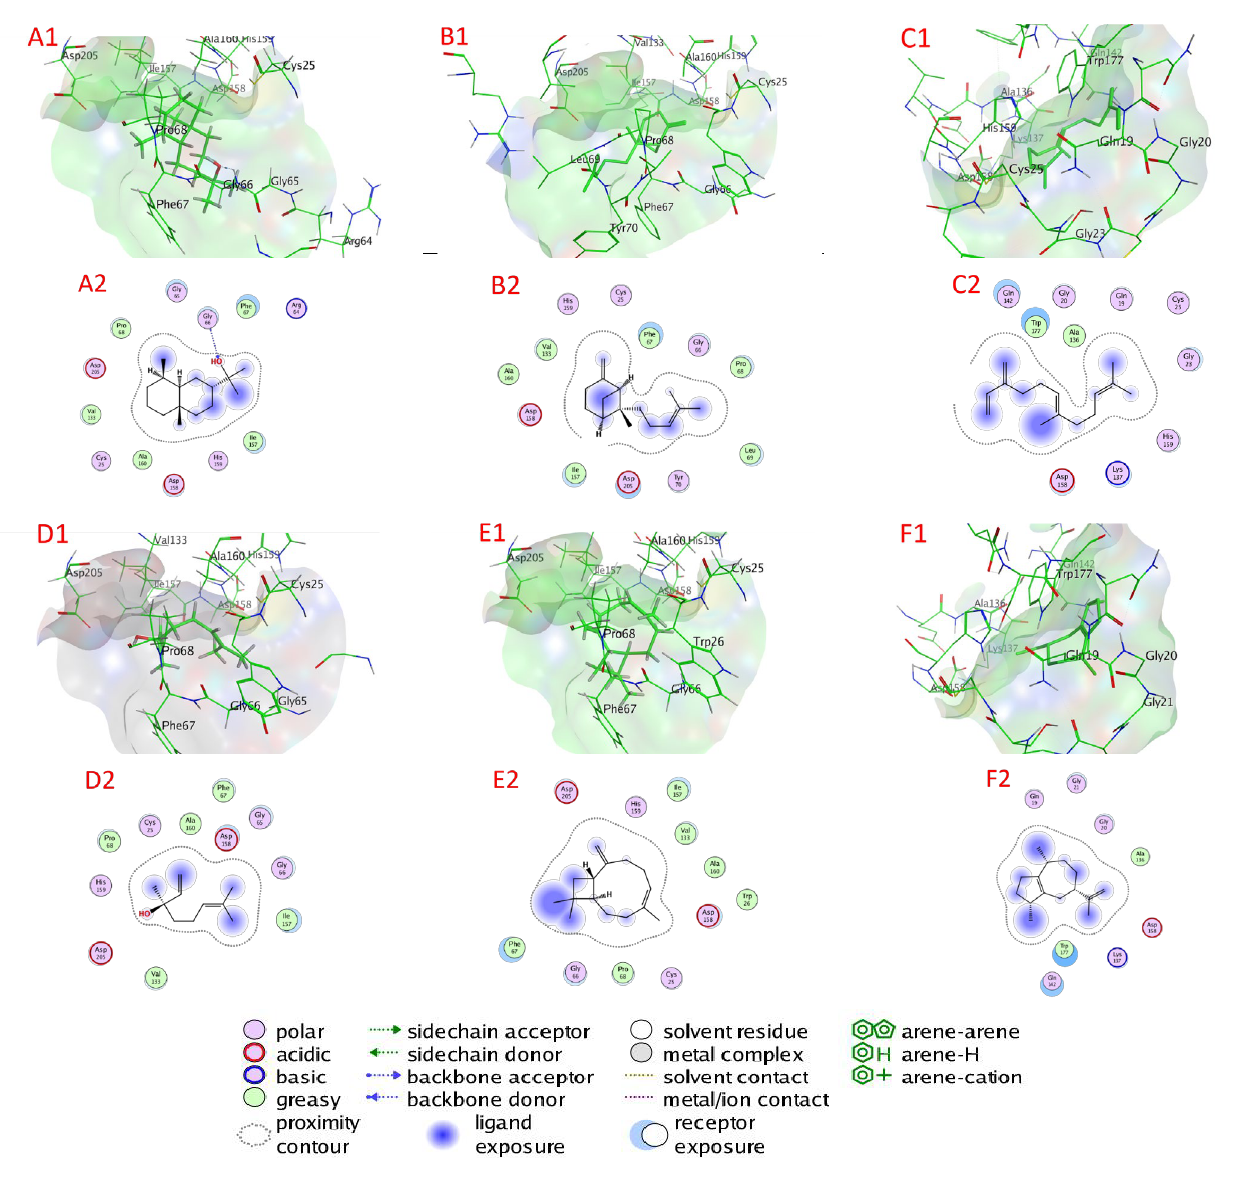
Figure 7. Docking view; ( A1 , A2 ) α -eudesmol, ( B1 , B2 ) β -bergamotene, ( C1 , C2 ) β -farnesene, ( D1 , D2 ) linalool, ( E1 , E2 ) β -caryophyllene, and ( F1 , F2 ) α -guaiene in the binding sites of cysteine protease (PDB:3IOQ). ( A1 , B1 , C1 , D1 , E1 , F1 ) 3D complex structures (stereoview) and ( A2 , B2 , C2 , D2 , E2 , F2 ) 2D interaction diagram